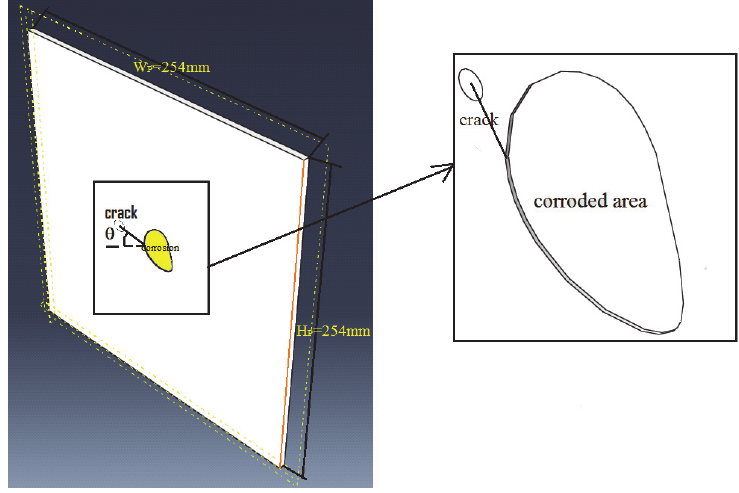
Figure 1: Geometrical